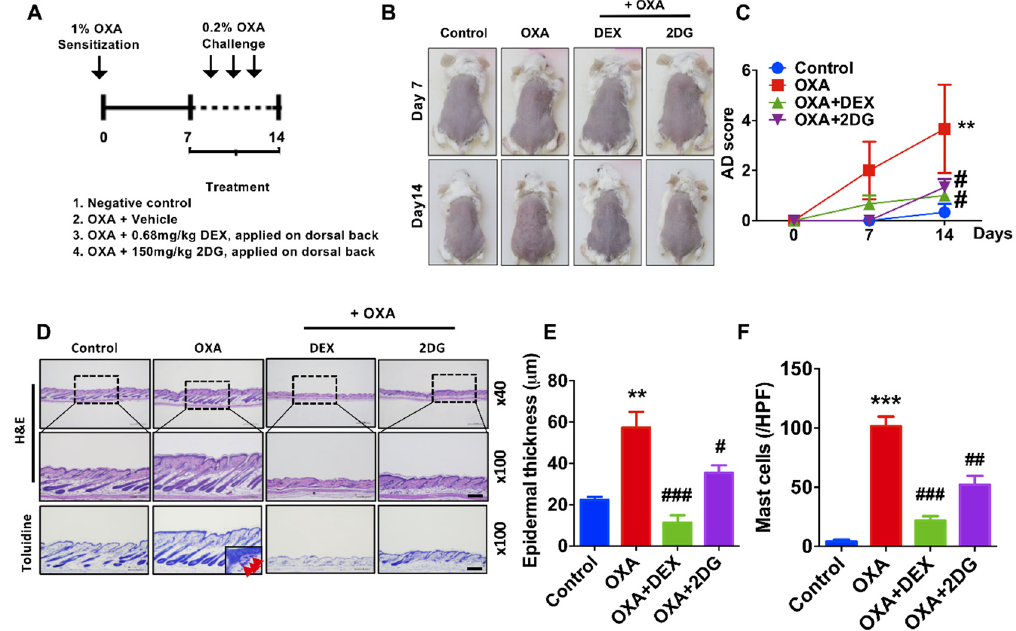
Figure 3. 2DG attenuates dermatitis in oxazolone (OXA)-induced animal model. ( A ) Schematic diagram of OXA-induced animal model. Four groups: untreated controls, OXA only and mice treated with DEX (Dexamethasone) or 2-dexoy-d-glucose (2DG) 1 h after every OXA challenge ( n = 3 per group). ( B ) Representative photographs of mouse ears from each group on day 14. ( C ) AD score was measured during treatment. ( D ) H&E staining and toluidine blue staining in dorsal skin lesions ( E ) Epidermal thickness ( µ m) was determined by micrometer. ( F ) Mast cells (red arrow) in dermis were counted. Scale bar, 200 µ m. Data are presented as mean ± SEM of changes in values. ** p < 0.01, *** p < 0.005 compared to control, # p < 0.05, ## p < 0.01 and ### p < 0.005 compared to OXA.